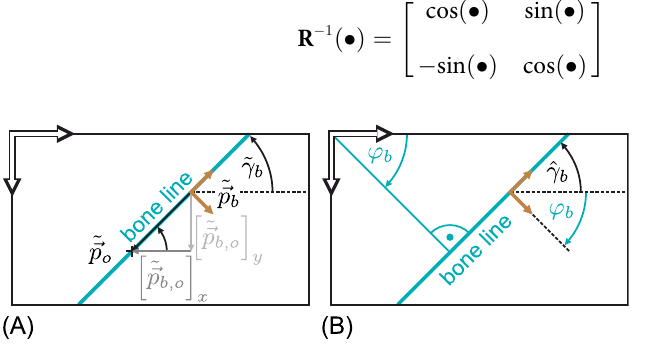
Fig 6. Bone line angle calculation in case of (A) the manual and (B) the automatic data extraction. A sketch which demonstrates how the bone line angle was calculated during manual data extraction ( ~ g ). (A) demonstrates the case of manual bone line labeling in which ~ g ( ^ g b in Eq (16). Analog (B) demonstrates how ^ g Fig 9) as formulated in Eq